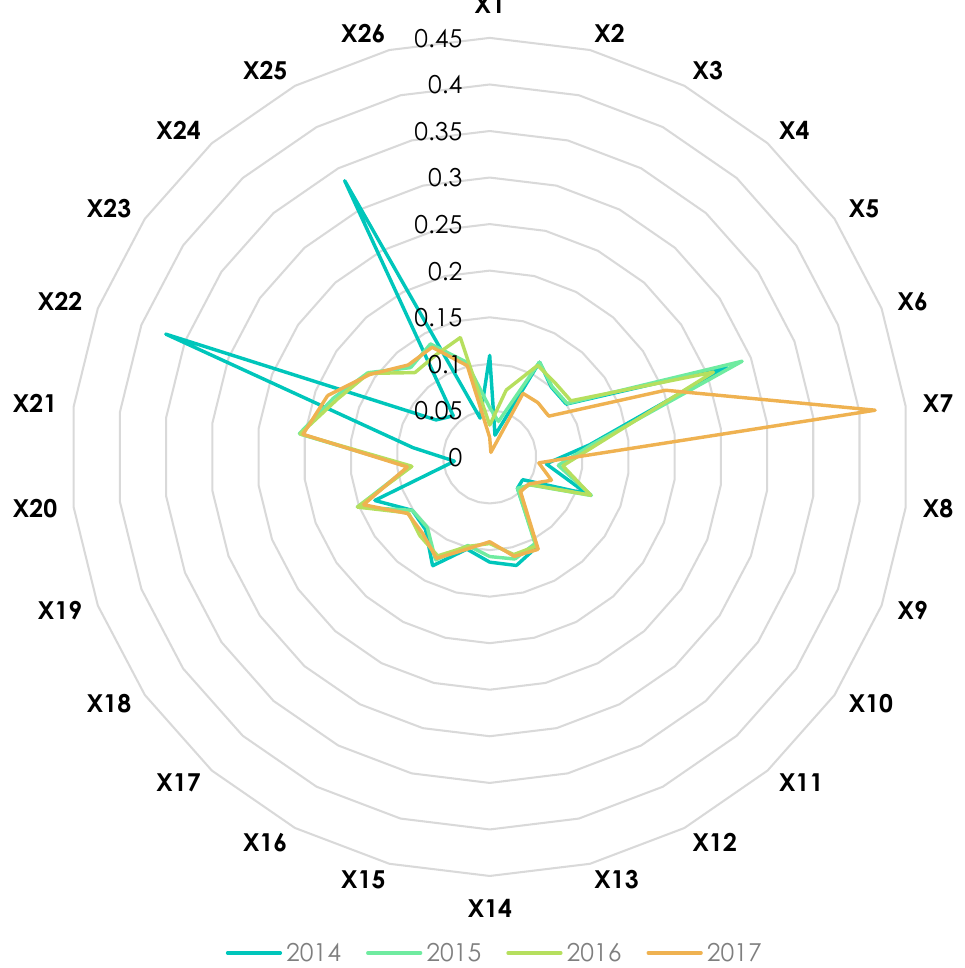
Figure 2. Evolution of the indicators used to describe population growth, land use and housing supply (2014 – 2017).